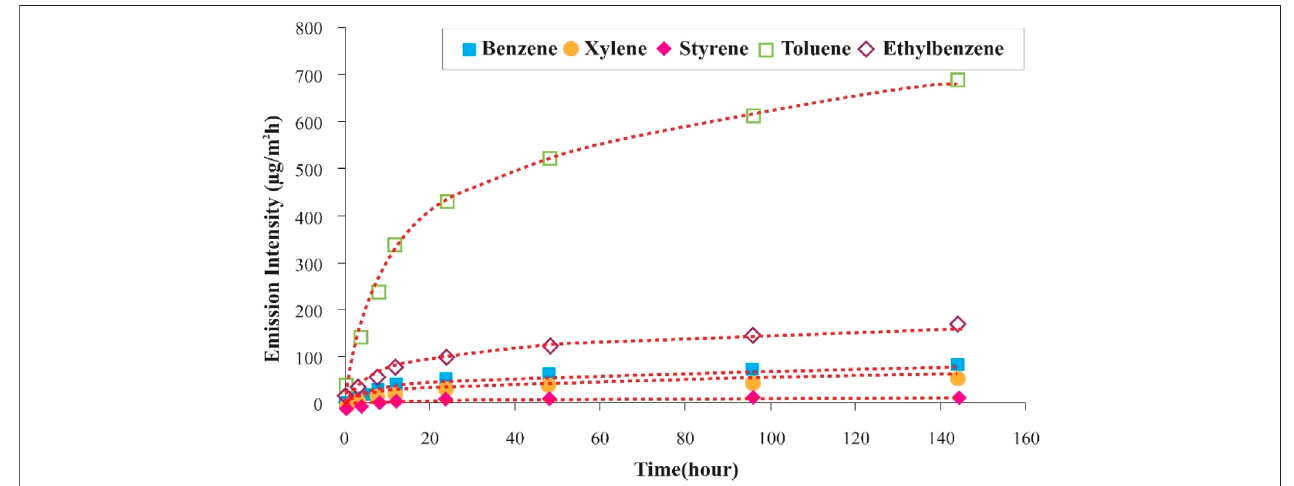
FIGURE 11 | Cumulative emission of VOCs from fl ooring.